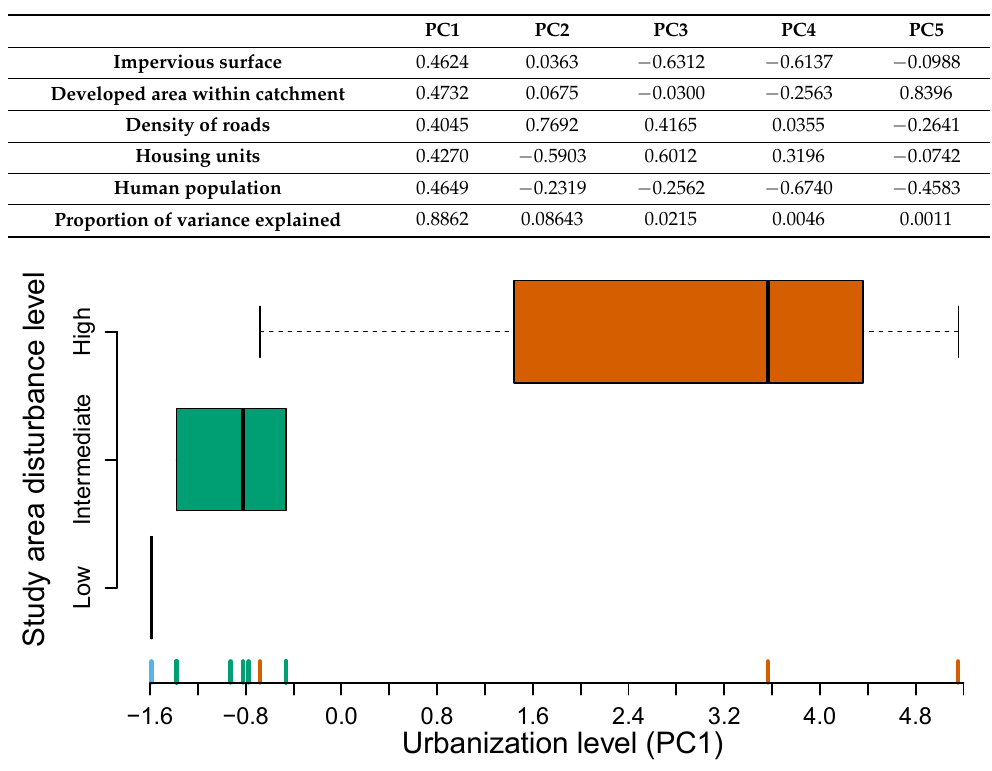
Figure 1. Level of human disturbance across study areas. Initial designation of human disturbance included three categories based on our observations (high, intermediate, low levels of disturbance). Principal component axis 1 (PC1) combines different metrics of human disturbance across study areas (see Table 2). Colored ticks along the x -axis indicate actual PC1 scores of each study area (some study areas within a human disturbance category have the same PC1 score).